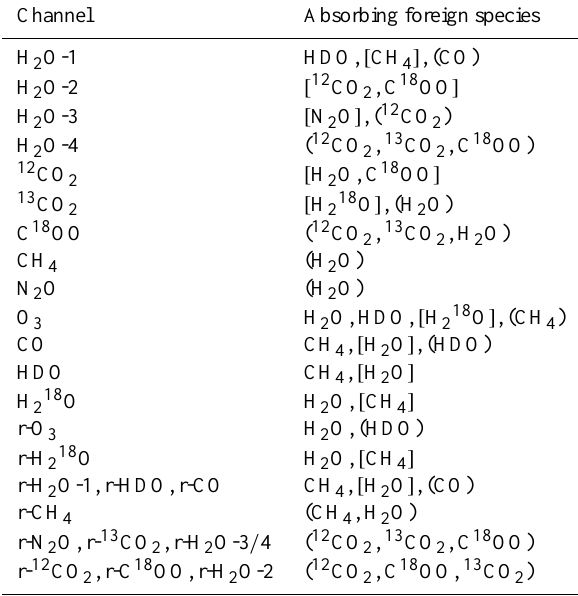
Table 2. Species mainly contributing to foreign species absorp- tion, ordered according to their influence in FASCODE STD con- ditions at 5km. Species without parentheses have major influence (larger or around 1dB), squared brackets mark small influence (be- low 0.5dB to 1dB), round brackets very small influence (below 0.25dB). These influence limits apply under all atmospheric con- ditions including TRO